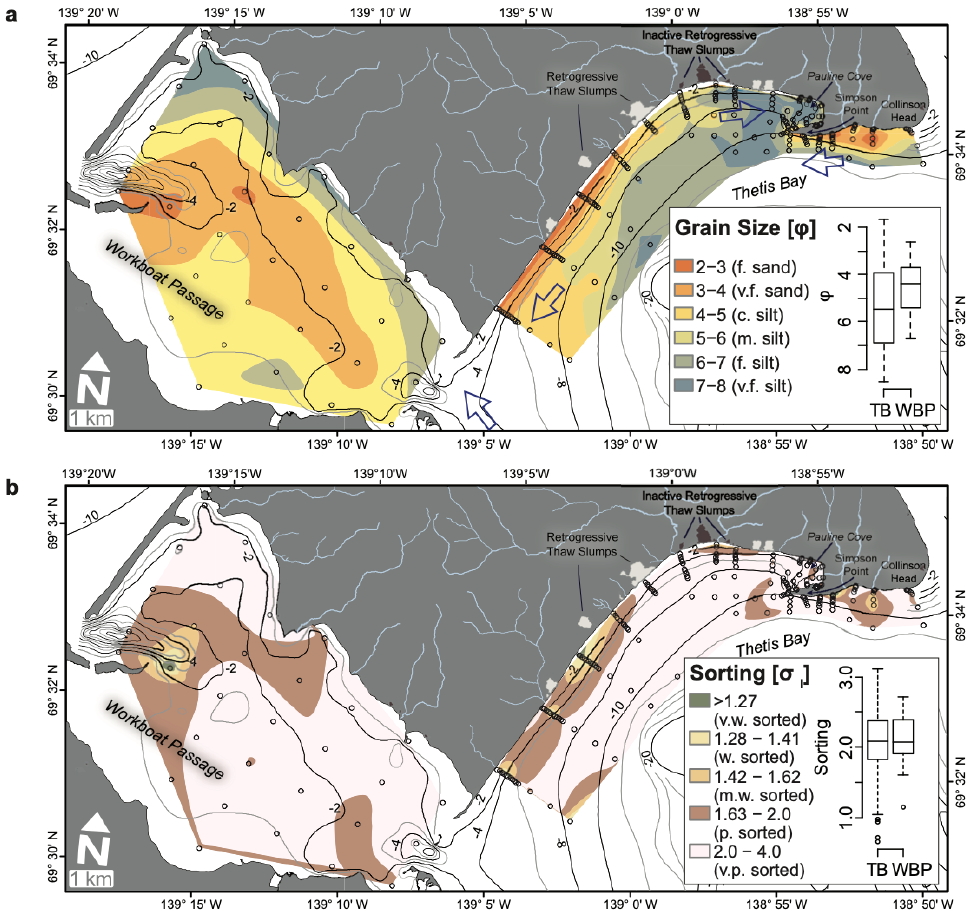
Figure 2. Spatial distribution and box plots of the ( a ) grain size mean and ( b ) sorting in the study area visualized using a natural neighbor interpolation and expressed in units of ϕ, where ϕ = − log2D, with D being the grain diameter in millimeters. Size classes are indicated as fine (f.), medium (m.), and coarse (c.). Sorting is very well (v.w.), well (w.), moderately well (m.w.), poor (p.), and very poor (v.p.). Sample locations shown as open circles. Blue arrows indicate dominant long- shore directions. Isobaths show 1 m contours in Workboat Passage (WBP), and 2 m contours in Thetis Bay (TB) [51,81,82].